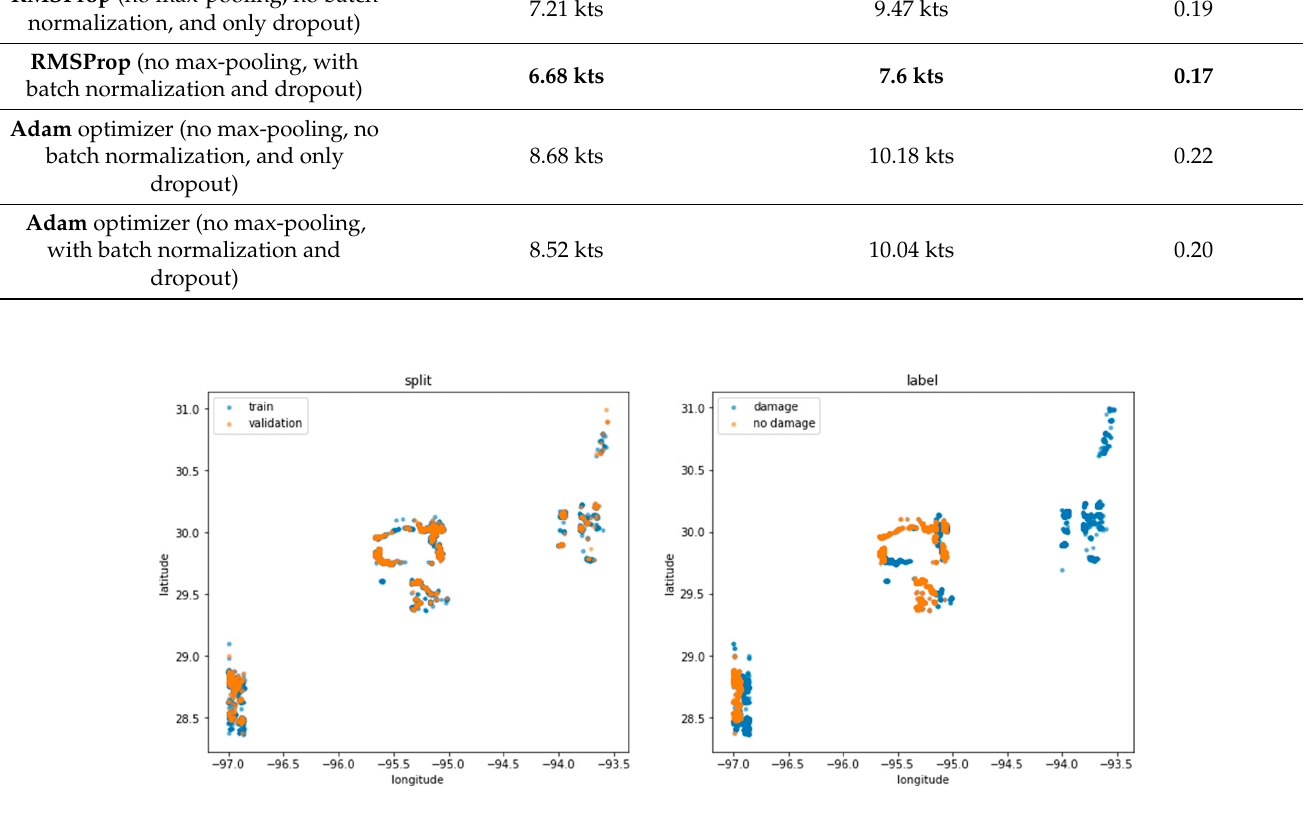
Figure 14. Training and validation test split.